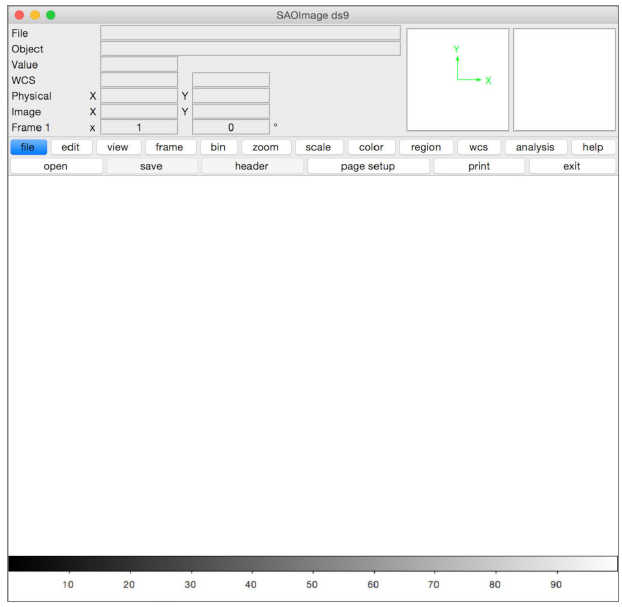
Fig. 33.— The initial screen of DS9 right after the software has started tion about the image(s); top right, two small windows we will talk about later. Below, there is a horizontal menu with two rows. I will call the top row the “main menu.” Whenever you click on a field in the top row, the bottom row will display a set of associated commands. I will call this bottom row the “secondary menu”.